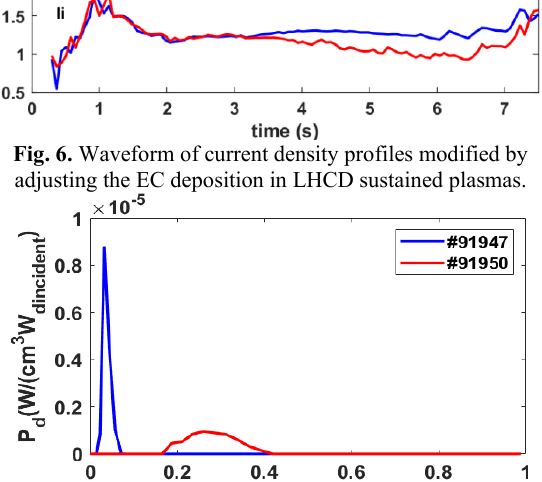
Fig. 7. Normalized power density profiles calculated with